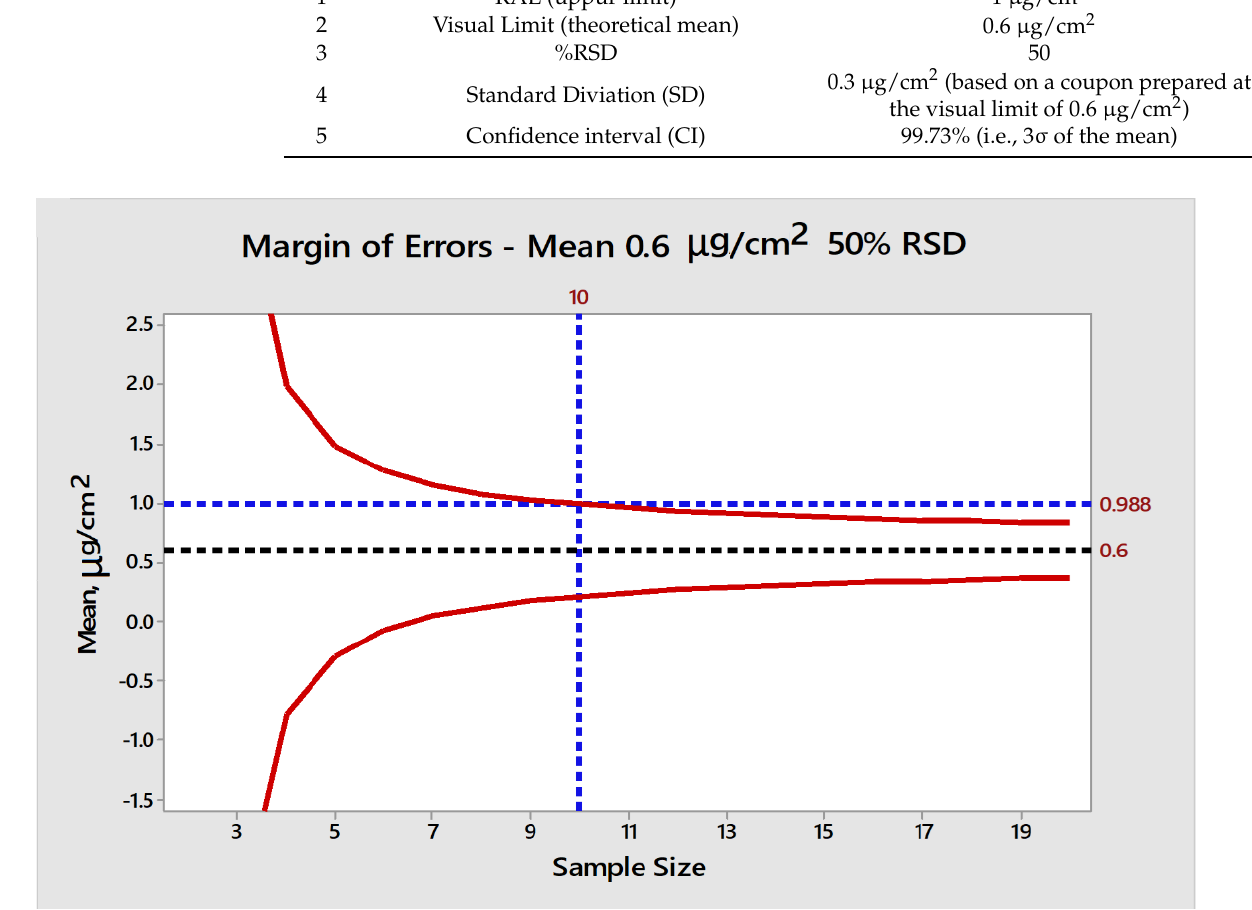
Figure 1. Calculated MOE for each sample size.